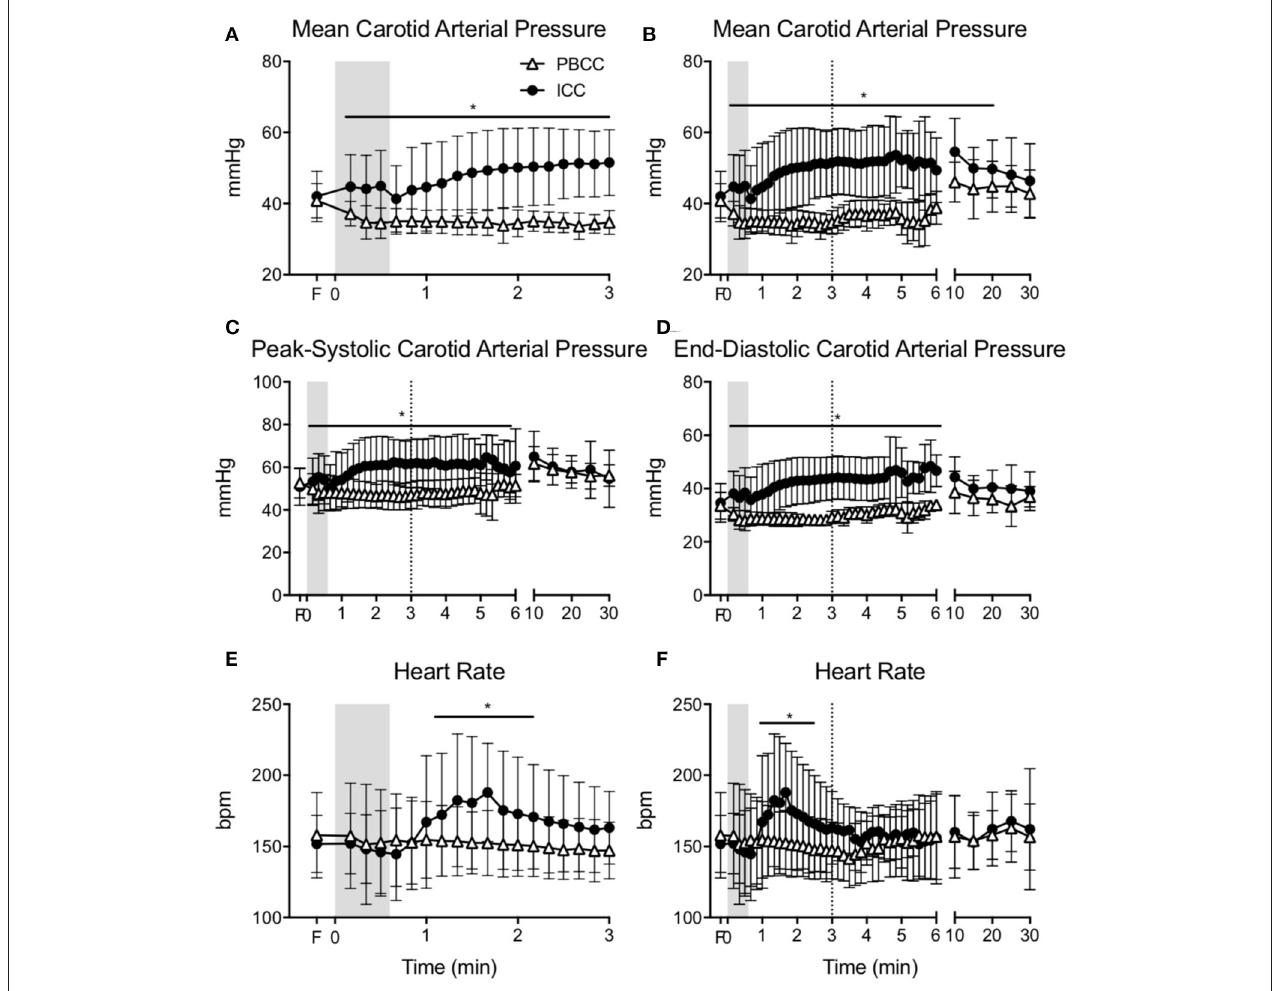
FIGURE 2 | (A) Mean carotid arterial pressure during the first 3min and (B) throughout the study, (C) peak-systolic, and (D) end-diastolic carotid arterial pressure, (E) heart during the first 3min, and (F) heart rate throughout the study measured in PBCC (open triangles) or ICC (closed circles) preterm lambs exposed to antenatal LPS for 7 days. Shaded region indicates the time between cord clamping and ventilation onset in ICC lambs. Dashed line represents time of cord clamping in PBCC lambs. *indicates significant difference between groups.